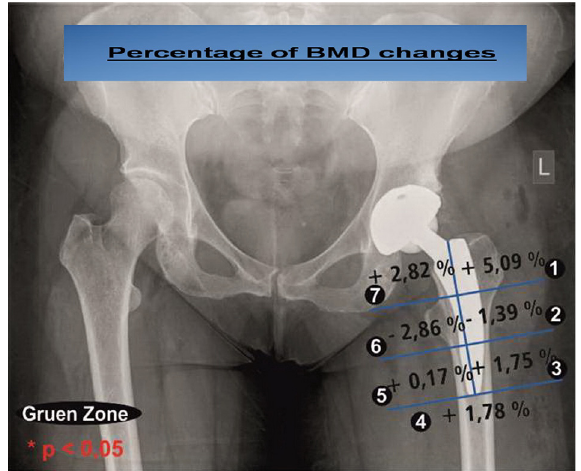
Figure 4. Periprosthetic bone density change six versus twelve months